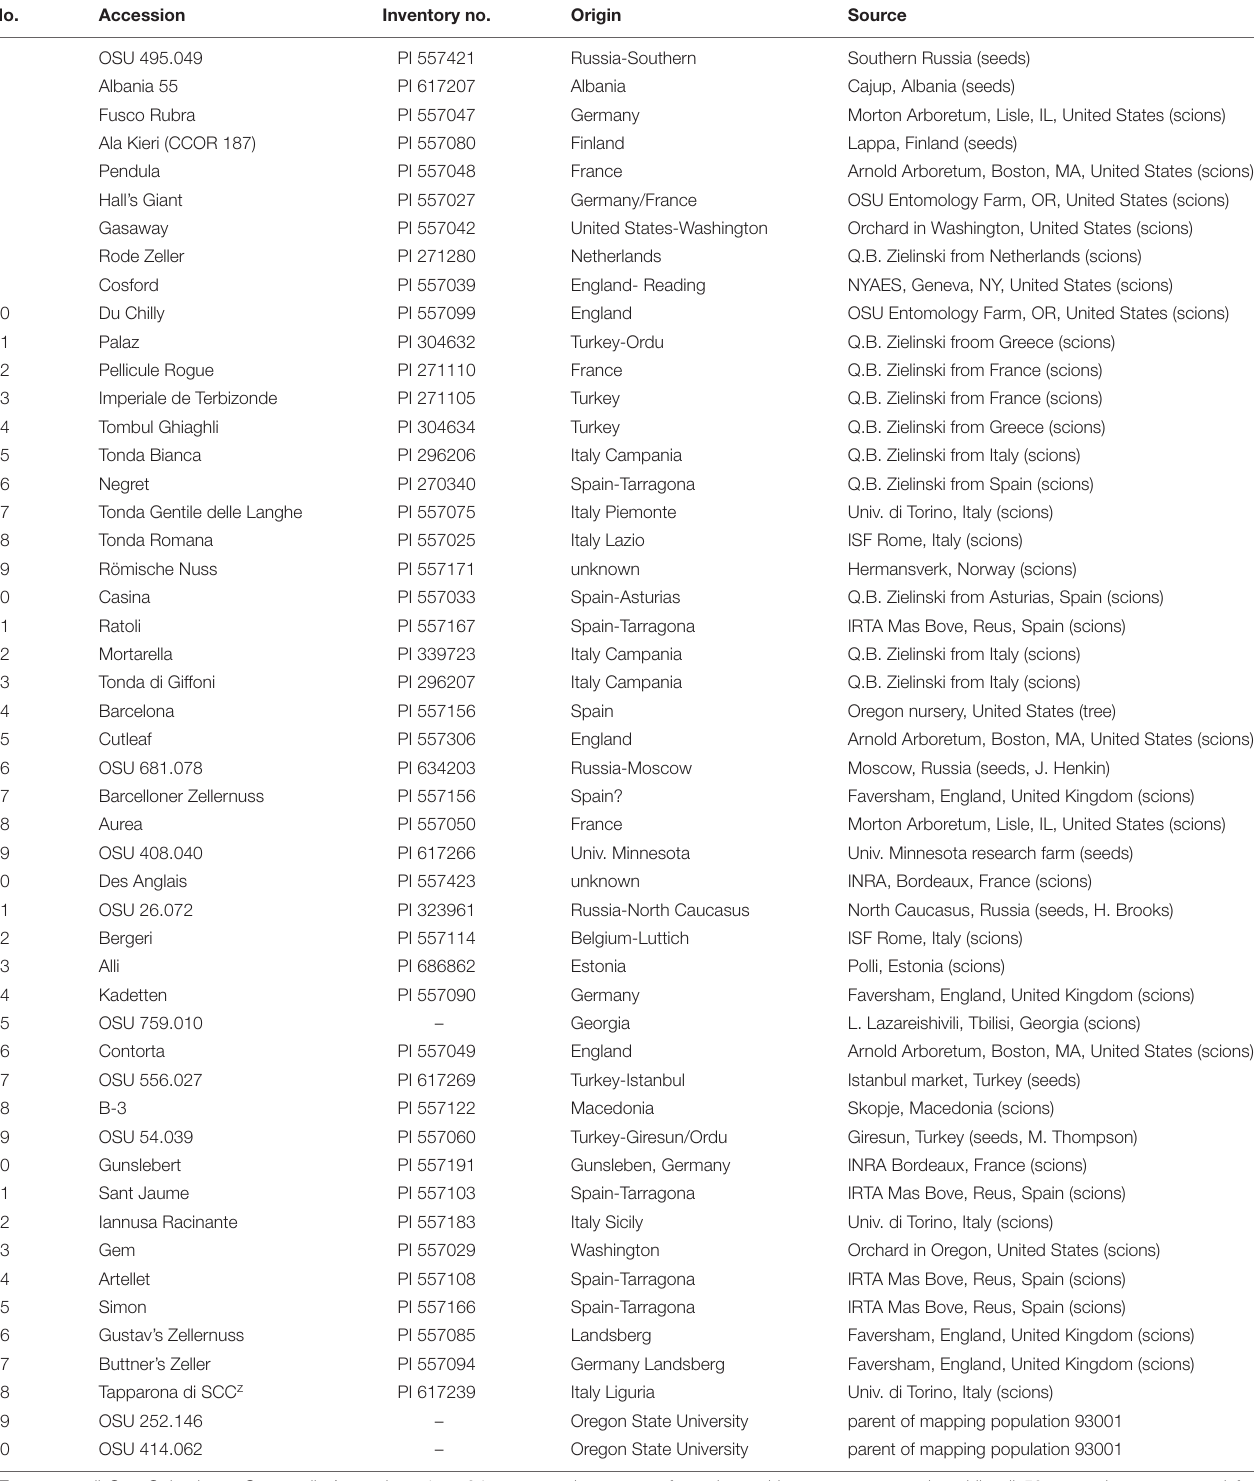
TABLE 1 | Hazelnut accessions used for characterization of 42 new polymorphic simple sequence repeat (SSR) markers.